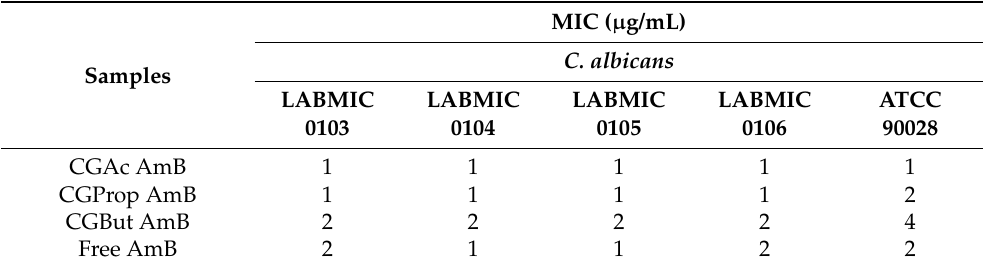
Table 3. Minimum inhibitory concentration (MIC) of AmB-loaded acylated nanoparticles against C. albicans